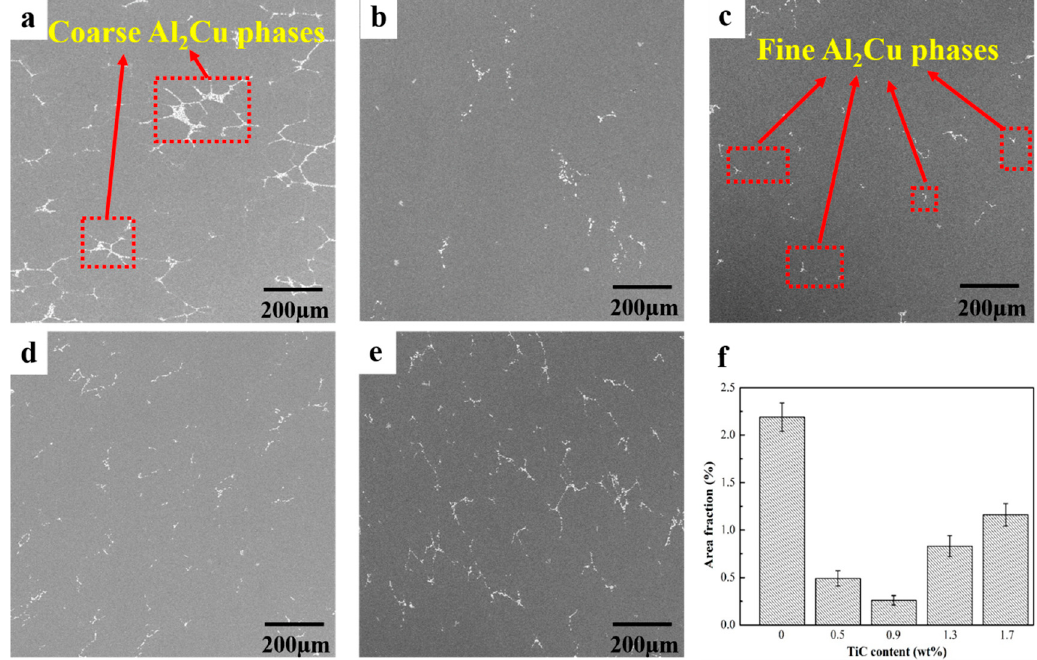
Figure 6. SEM images of the forged and heat-treated TiC/2219 nanocomposite with different nanoparticle contents: ( a ) 0 wt.%, ( b ) 0.5 wt.%, ( c ) 0.9 wt.%, ( d ) 1.3 wt.%, and ( e ) 1.7 wt.%; ( f ) the area fraction of Al 2 Cu phases in TiC/2219 nanocomposites.